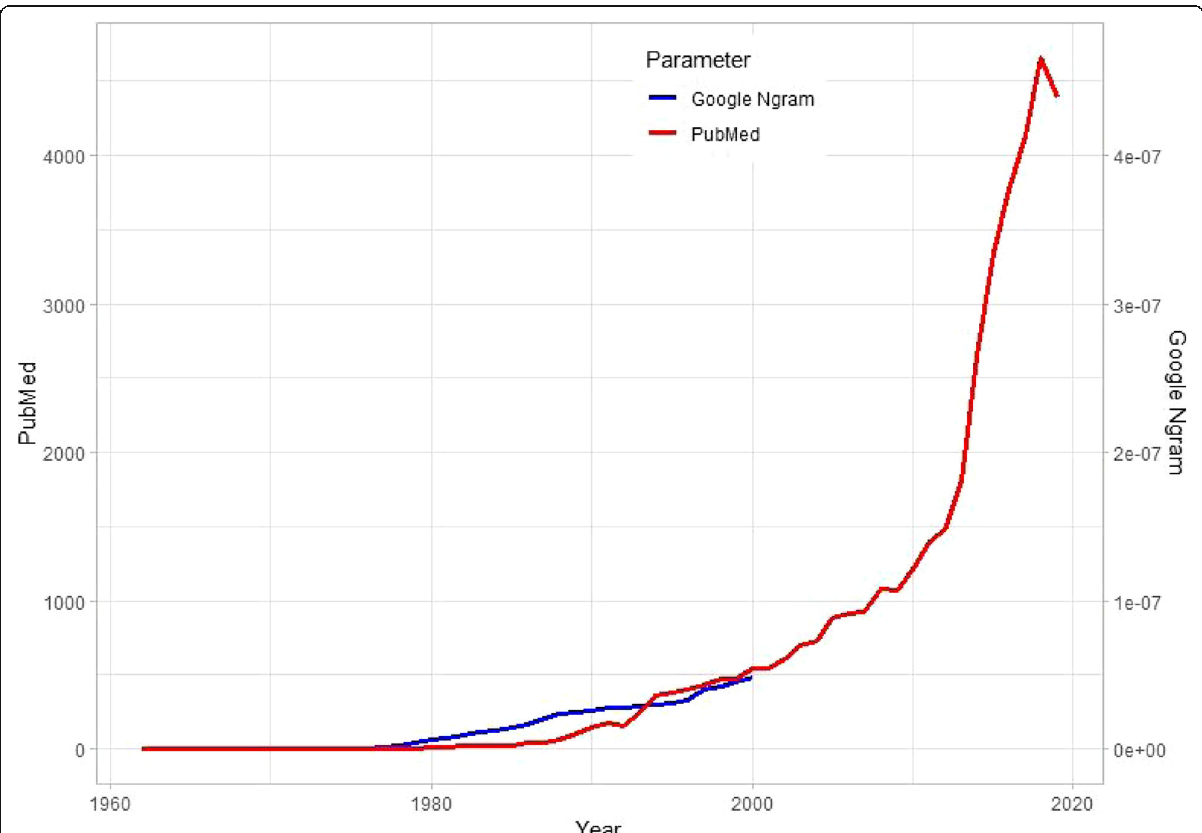
Fig. 1 A graphical representation of texts indexed under word string ‘ interventional radiology ’ on Google English corpora and PubMed between 1960 and 2019. There is an exponential rise in quotation of ‘ interventional radiology ’ on PubMed and indexed compilation on